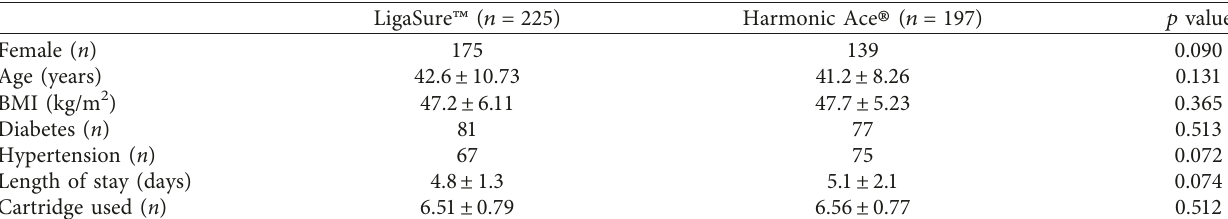
Table 1: Characteristics of study population.